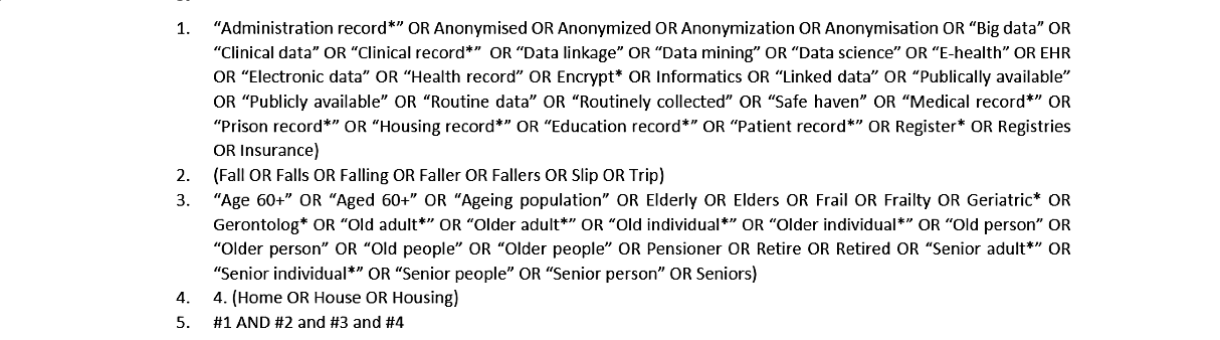
Figure 1. Search strategy for